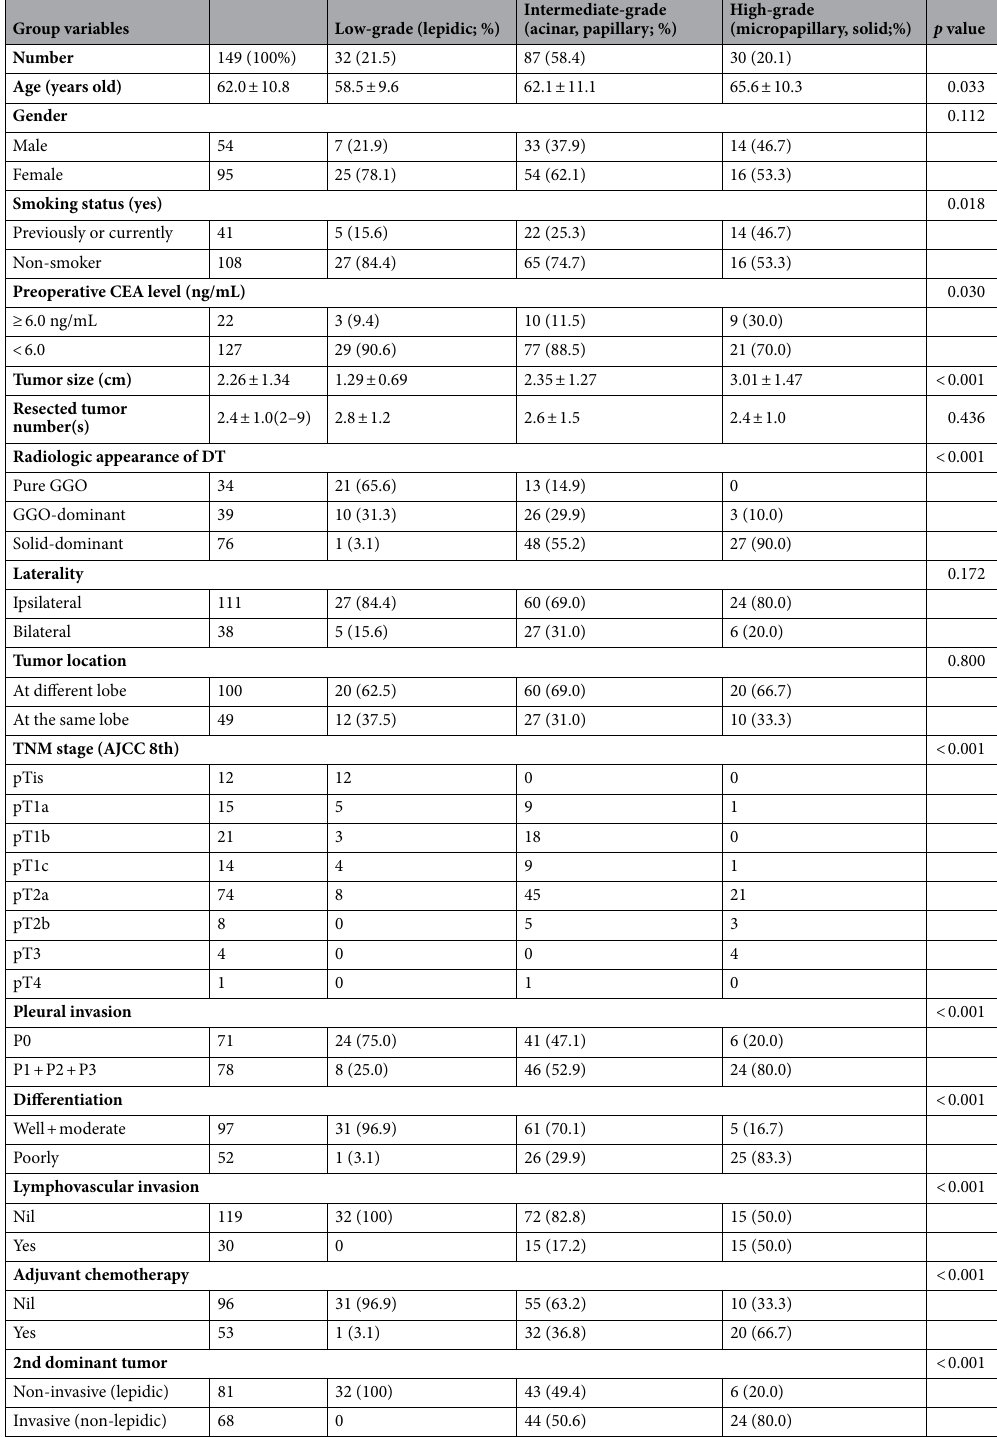
Table 1. Demographic and clinical characteristics of 149 patients with SMADCs, grouped by IASLC/ATS/ERS classification of dominant tumor (DT). DT dominant tumor of SMADCs, AIS adenocarcinoma in situ, MIA minimal invasive adenocarcinoma, CEA carcinoembryonic